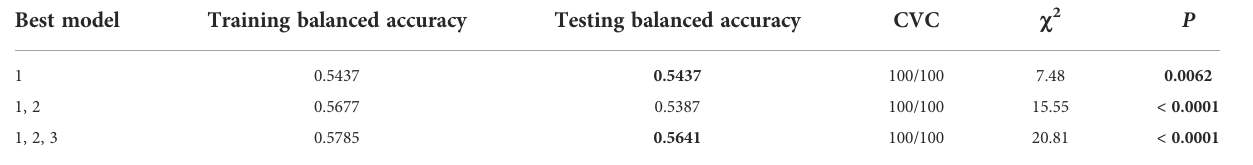
TABLE 7 MDR analysis for the PE risk